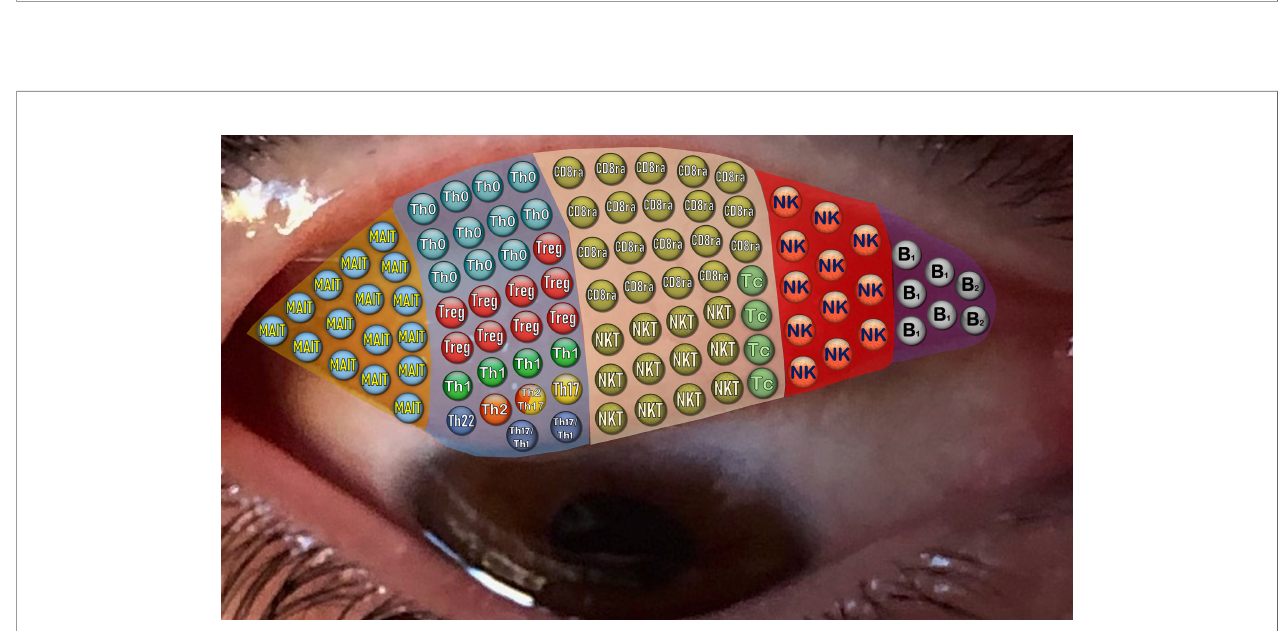
FIGURE 4 | Picture showing lymphoid subpopulation proportions in healthy conjunctiva using spheres. Different colored regions represent MAIT, CD4 T, CD8 T, NK and B cells, randomly observed in the conjunctiva. As can be seen, there is a fairly abundant mucosal associated invariant T (MAIT) cell population expressing CD3+ but not CD8 and CD4. Note that T cells are predominantly CD8+, being almost 50% CD8 memory T cells (CD45r0), with a NKT cell predominance. In contrast, CD4 lymphocytes are mainly memory T cells, with a Treg predominance. Finally, B1 cells predominate over B2 cells in the CD19+